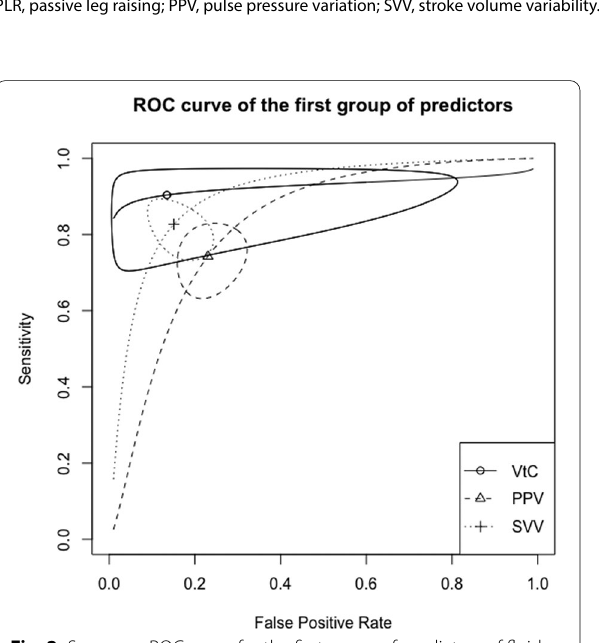
Values are expressed as pooled value (95% confidence interval). AUC, area under curve; I 2 , inconsistency; DOR, diagnostic odds ratio; EEOT, end expiratory occlusion; PLR, passive leg raising; PPV, pulse pressure variation; SVV, stroke volume variability. Values are expressed as pooled data (95% confidence interval)